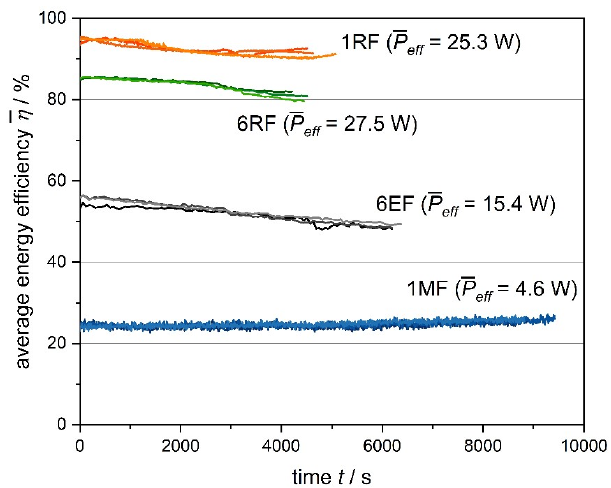
Figure 12. Average energy efficiency from MFD experiments plotted over drying time for different control concepts. Experiments were conducted in triplicate. P ef f denotes the effective power averaged across the respective repetitions.